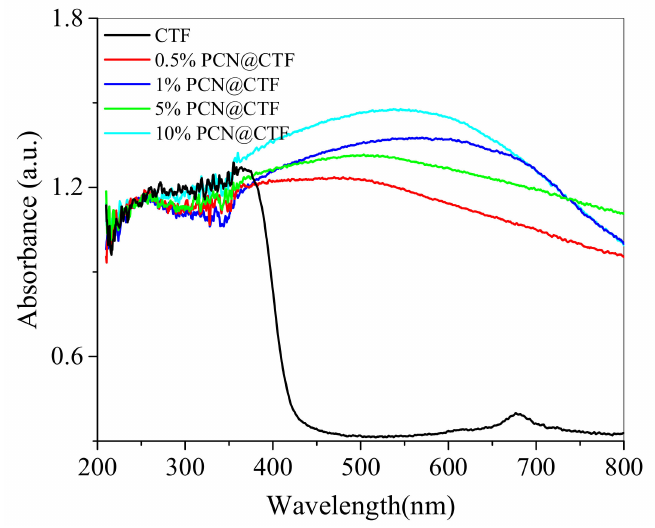
Figure 4. UV/Vis absorption spectra of CTF and x